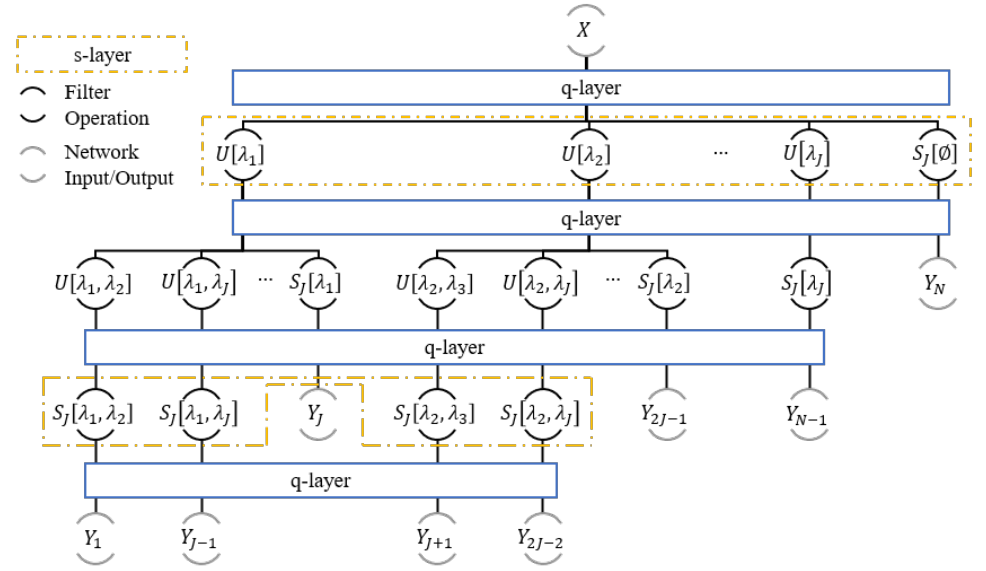
Figure 3. Location of the q-layers in an M = 2 WSN where L = 1.